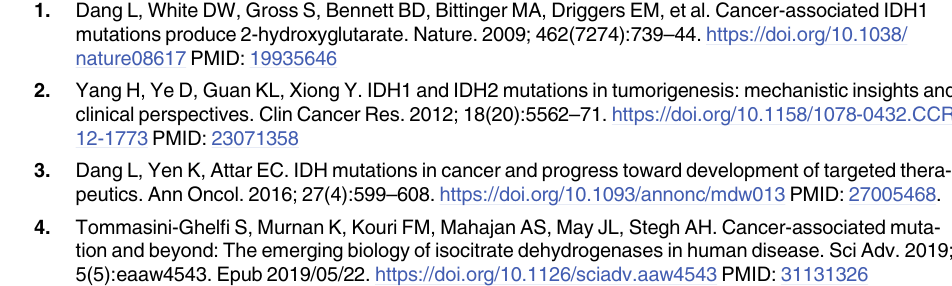
S3 Fig. Underlying mechanism of Glut1 expression regulated by mutant IDH1/2 through the PI3K/Akt/mTORC1-Hif1 α axis. Red solid arrows indicate the mechanism elucidated in this research. Black solid arrows show regulatory effects reported previously. Black dotted arrows exhibit potential regulations remaining unknown. S1 Table. List of the genes with altered expression by the IDH2 mutant or 2-HG treatment. S2 Table. Gene sets enriched in MEF-2MUT cells. S3 Table. Gene sets enriched in 2HG treated